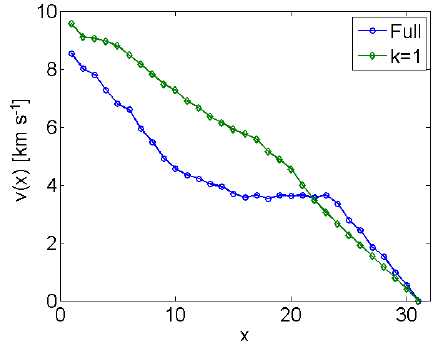
Figure 18. Velocity profiles assuming different levels of constant